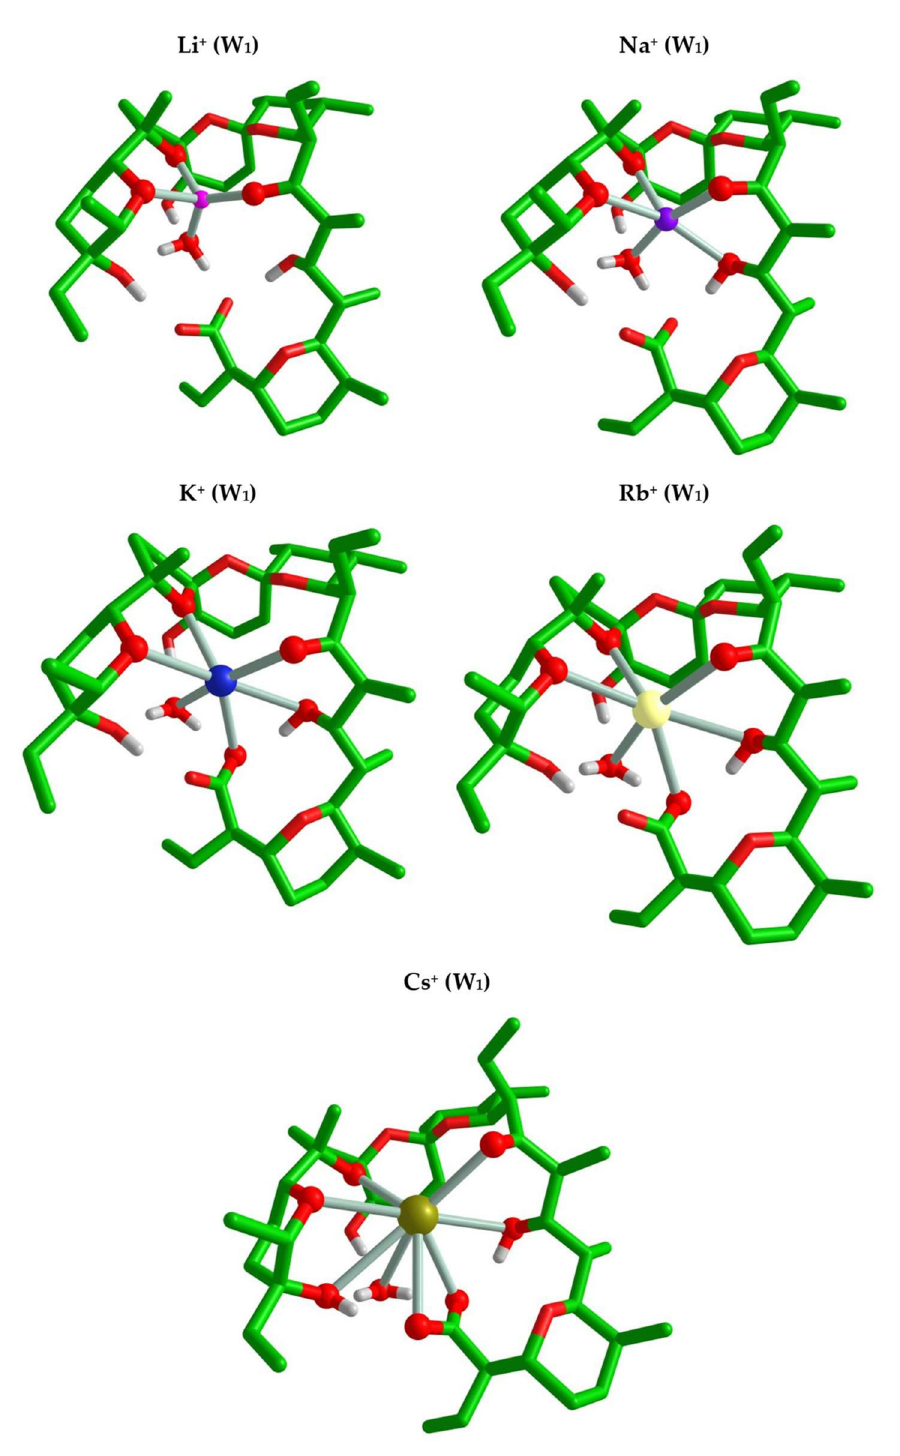
Figure 2. B3LYP/6-31+G(d,p) fully optimized structures of salinomycin complexes with Li + , Na + , K + , Rb + and Cs + cations, containing one (W 1 ) water molecule. Color scheme: C—green, O—red, H—light grey, Li—magenta, Na—purple, K—blue, Rb—yellow, Cs—deep olive (carbon hydrogens are omitted for